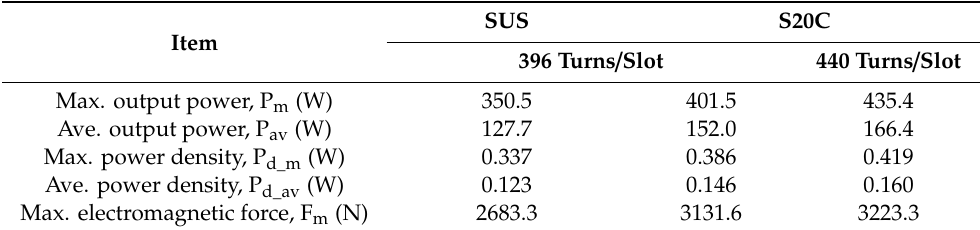
Table 5. Machine’s performance following changes.